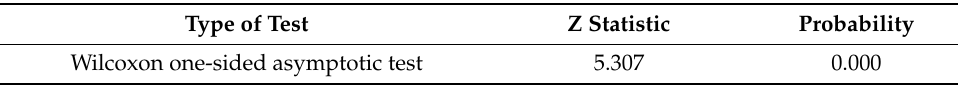
Table 4. The results of the